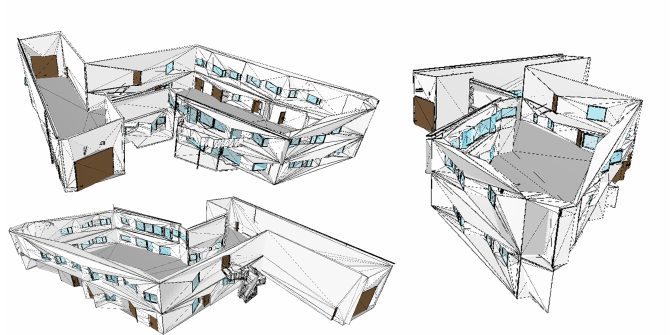
Figure 7. Views of the Myran model converted to CityGML by the test AGIS-FME-IFCr-L1, visualized in azul. In this case, the roof is